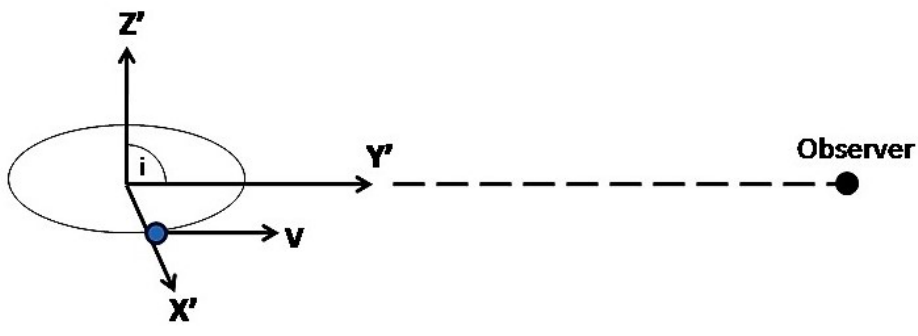
Figure A1. A stationary distant observer is located on the y (cid:48) − axis (i.e., v sys = 0, sin ( i ) = 1). Such an observer would measure a value of V for the line of sight velocity, thus, relying on relation (A1), would extract a value of V for the rotational velocity. As can be seen in the figure, this value is valid relative to the system K (cid:48) . At any other frame which is rotating relative to K (cid:48) , the rotational velocity would take a different